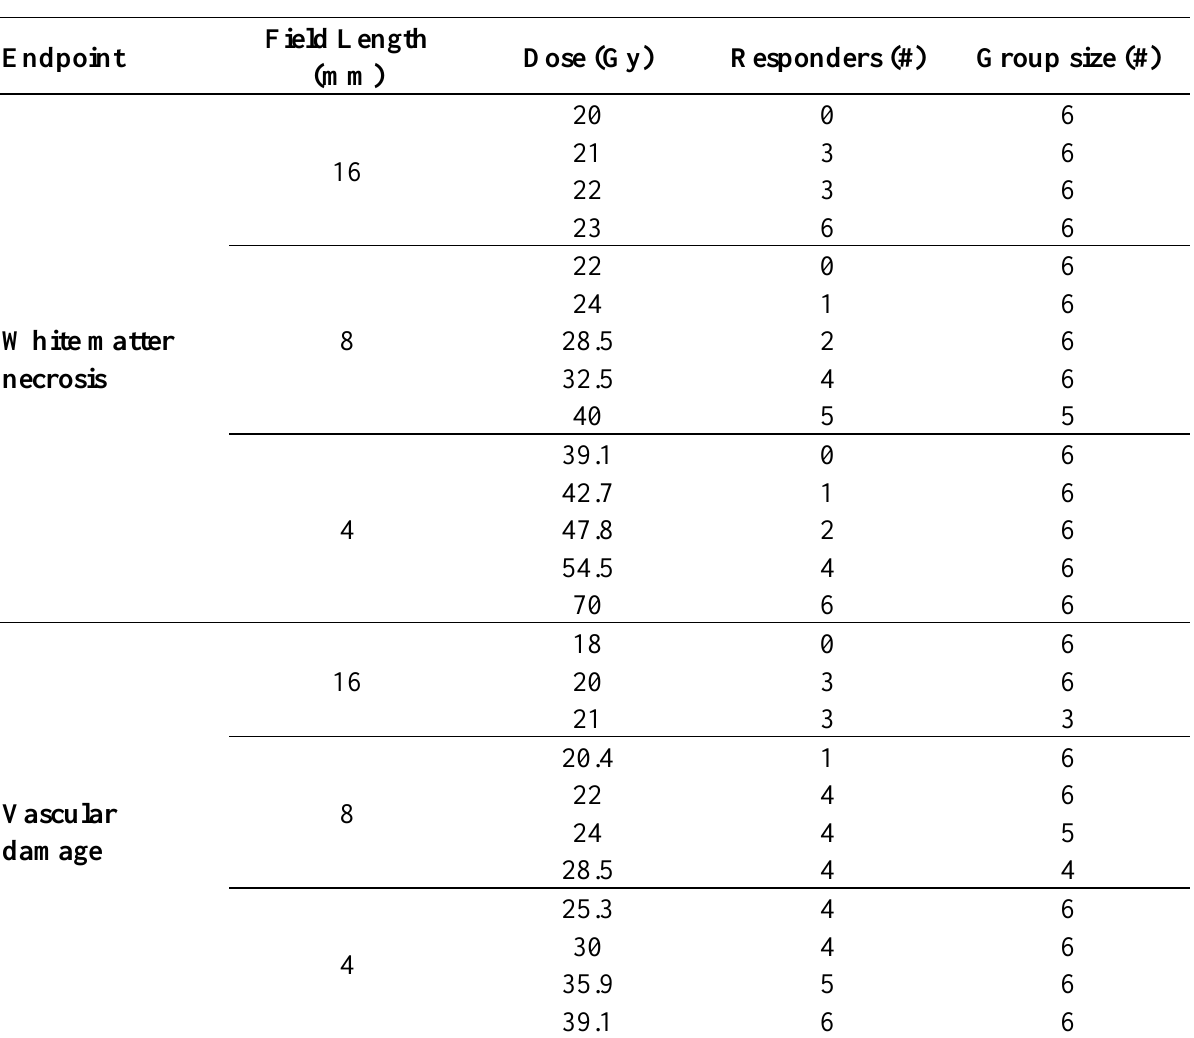
Table 2. Dose-response data for developing white matter related spinal cord paralysis (white matter necrosis) within 30 weeks and paralysis or histological evidence of vascular lesions (vascular damage) after a latent interval of >30 weeks after single dose irradiation of the rat spinal cord